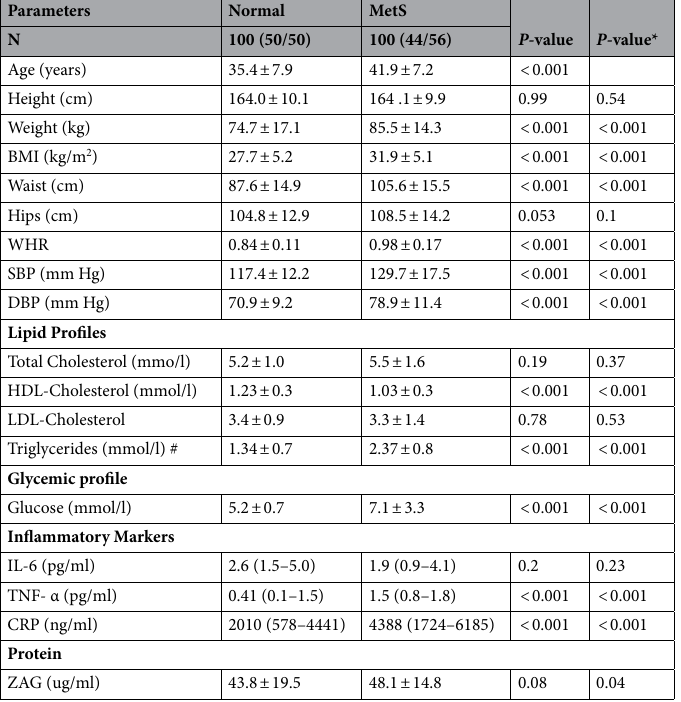
Table 1. Clinical characteristics of all subjects. Data presented in mean ± SD and median (25th–75th) percentiles. *Denotes P -value adjusted for age P -value significant at P < 0.05, 0.01